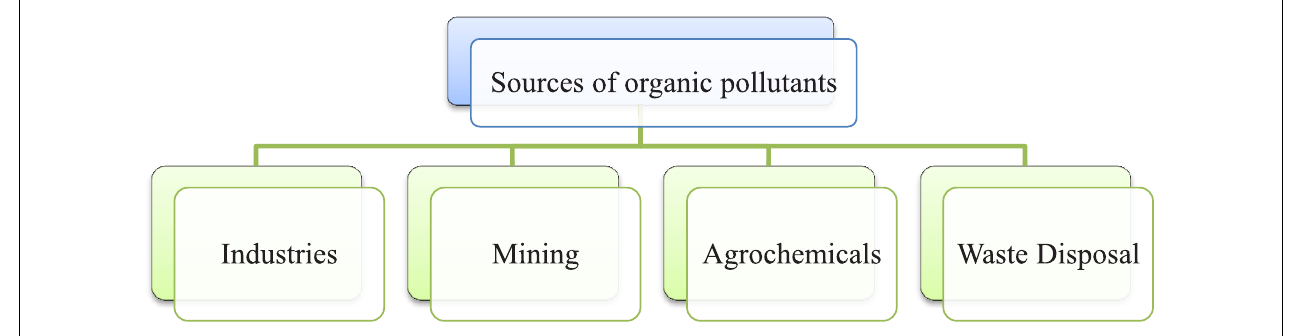
FIGURE 1 | Various sources of organic pollutants impacting the